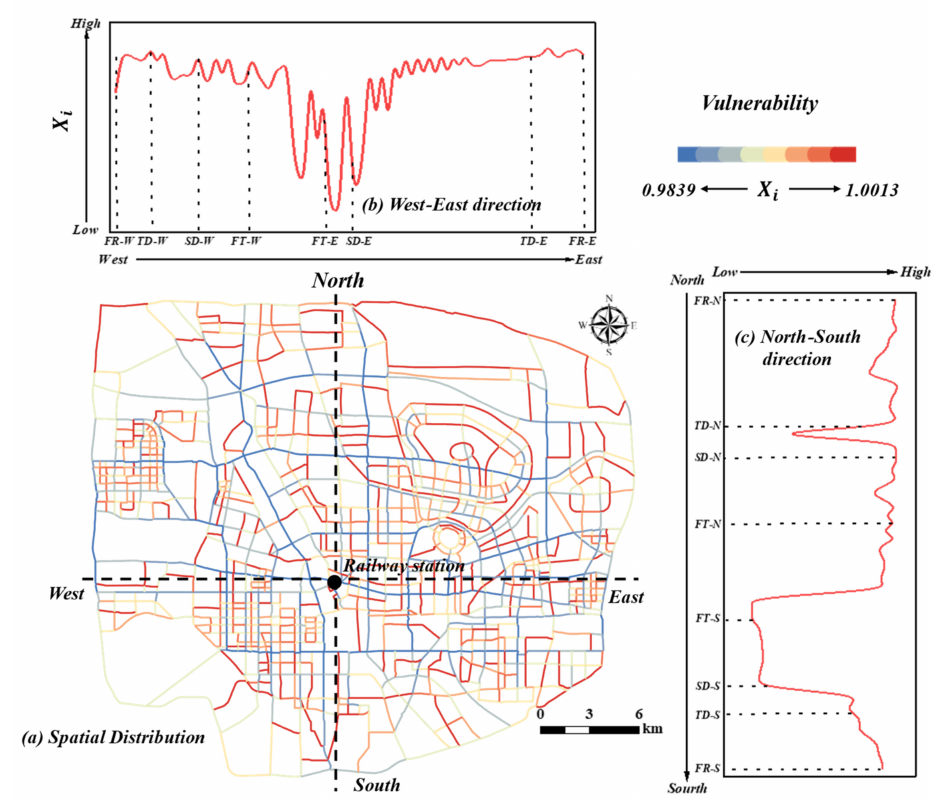
Figure 6. ( a ) Spatial distribution of road vulnerability; ( b ) differences in road vulnerability in the west–east direction; ( c ) differences in road vulnerability in the north–south direction. FR, TD, SD, FT stands for the 4th, 3rd, 2nd, and 1st Ring Road, respectively; N, S, W, and E stand for the north, south, west, and east directions.